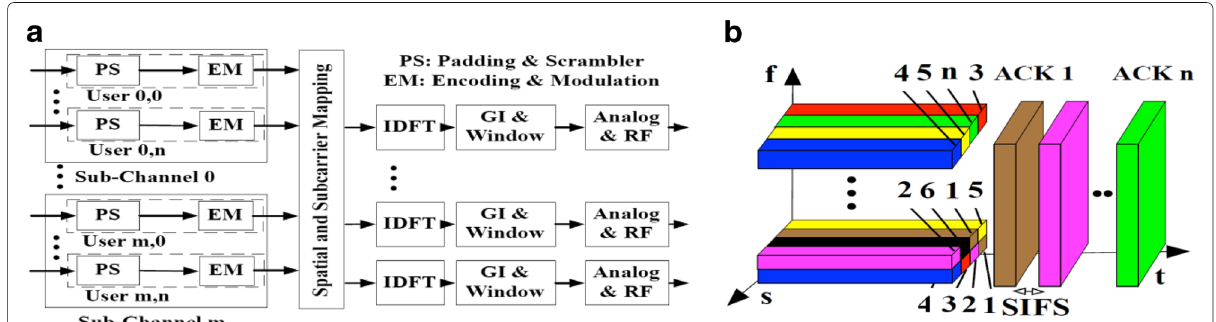
Fig. 7 SAMU MAC and PHY design: a transmitter block diagram of SA-HE mode and b transmission and acknowledgement in SA-HE. There are n users, and at each sub-channel, four users are grouped together. The set of users at different sub-channels may or may not overlap